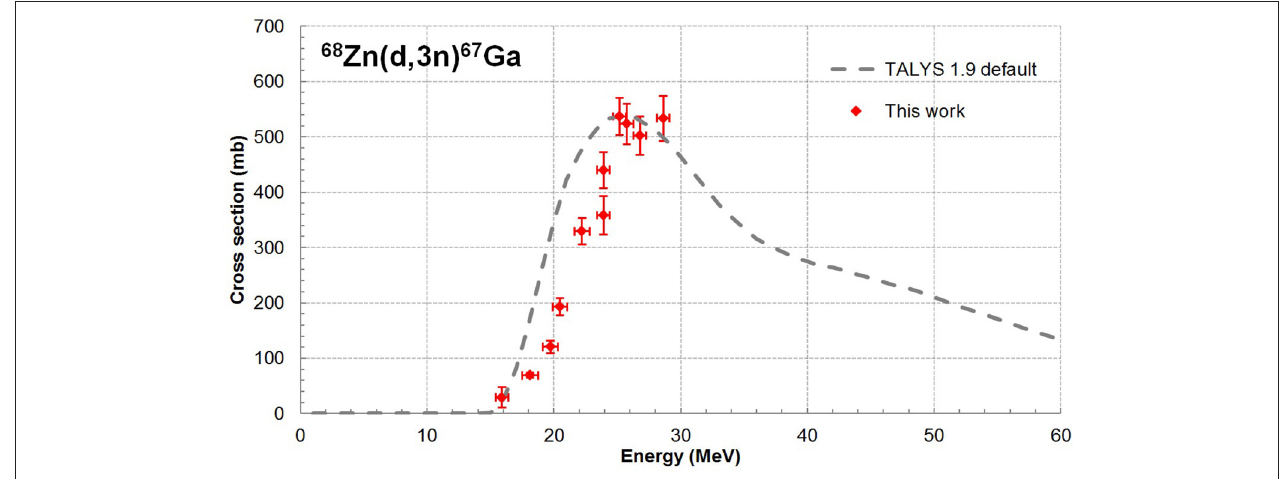
FIGURE 3 | Cross sections of the 68 Zn(d,3n) 67 Ga